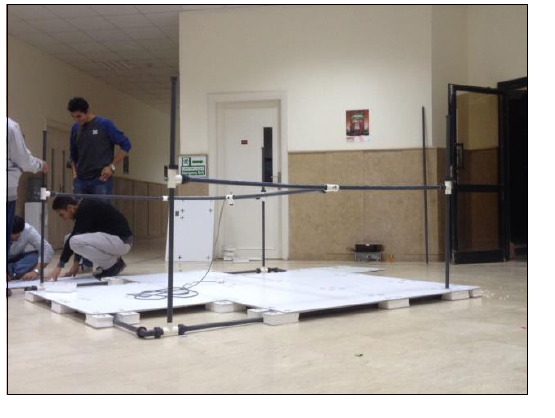
Figure 7. The students during the manufacturing and assembling of the